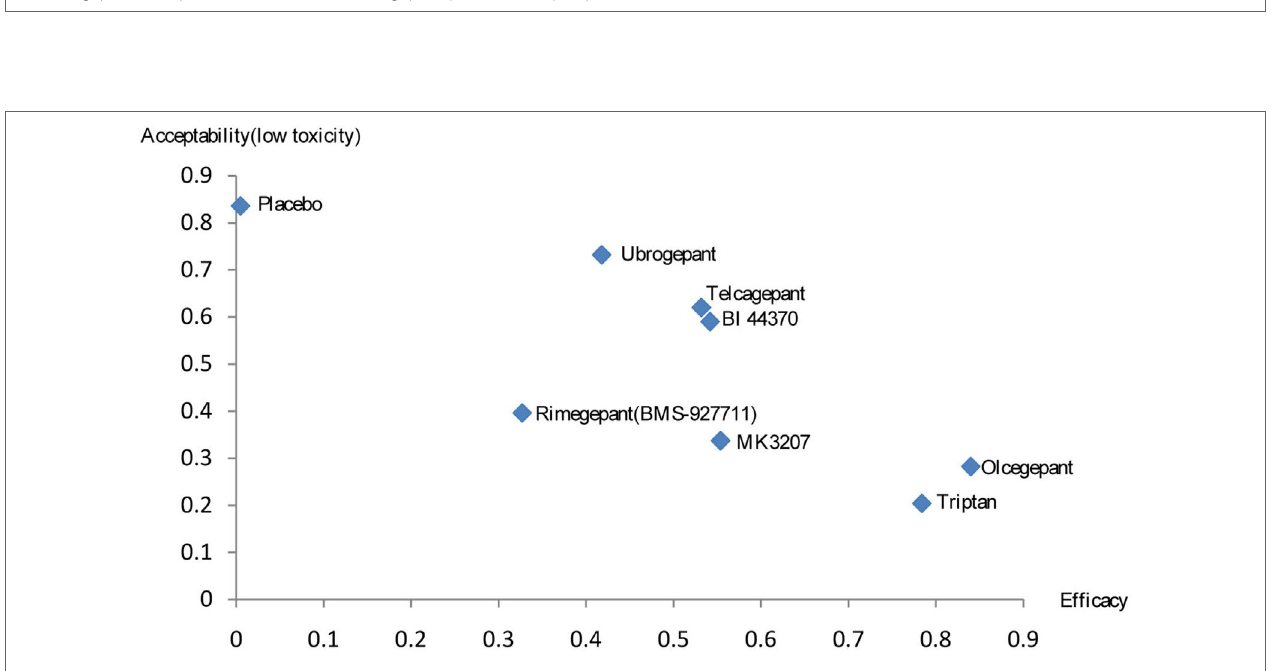
FIGURE 5 | Drug-related adverse events analysis of six treatment modalities. OR, odds ratio; CI, confidence interval; PrI, predictive interval; O, olcegepant; Te, telcagepant; Tr, triptan; M, MK3207; Bm, rimegepant (BMS-927711); P, placebo.